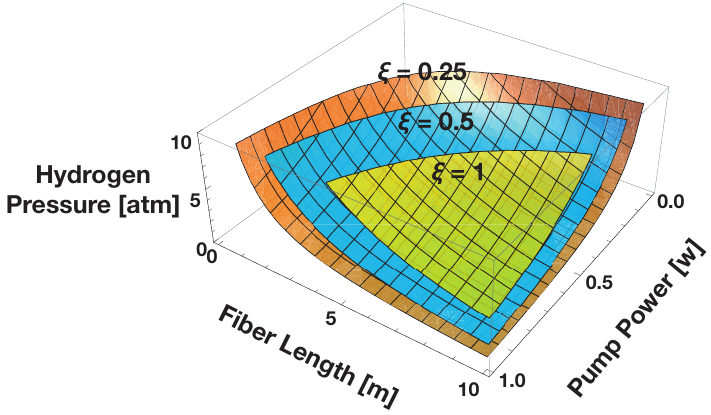
Figure 4. Contour curves for ξ = 0.25,0.5,1 as a function of hydrogen pressure, the hollow-core photonic crystal fiber (HC-PCF) length, and the pump